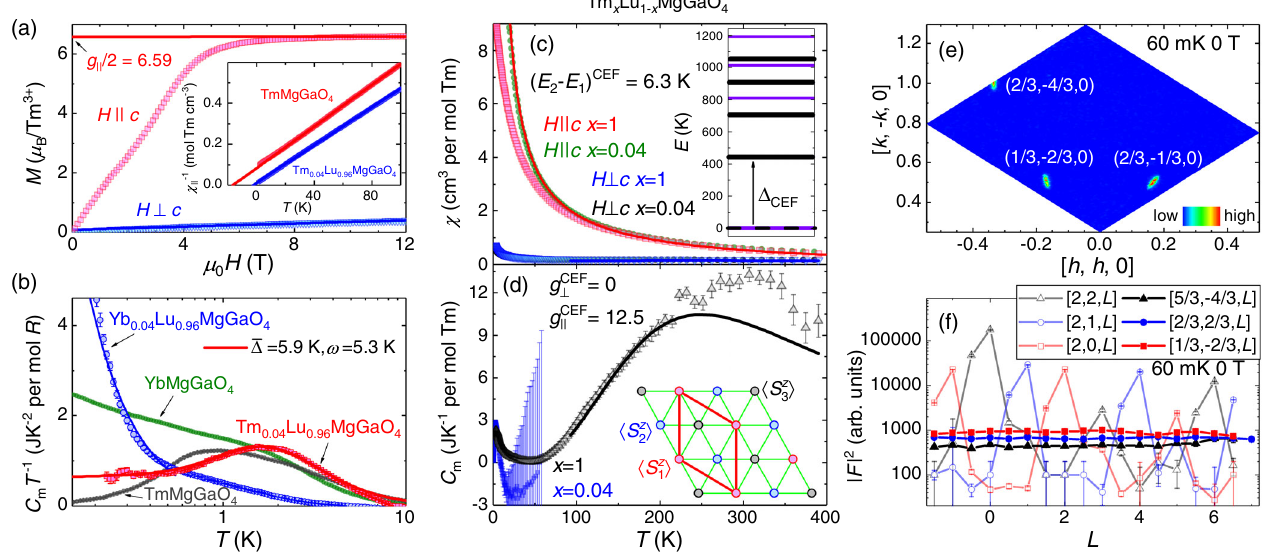
FIG. 1. (a) Magnetization of TmMgGaO 4 measured at 1.9 K in the fields parallel and perpendicular to the c axis. The colored lines show the linear fits to the data above 8 T. Inset: Curie-Weiss fits to the susceptibilities of TmMgGaO 4 and Tm 0 measured at 0.1 T along the c axis. (b) Magnetic heat capacities ( C Yb 0 Lu 0 MgGaO 4 at 0 T. The red and blue lines show, respectively, the fits to the data for Tm 0 . 04 . 96 Yb 0 Lu 0 MgGaO 4 with the Lorentzian distributions of E 2 − E 1 . (c) Temperature dependence of susceptibilities measured in the . 04 . 96 field of 0.05 Tapplied both parallel and perpendicular to the c axis. The inset shows the CEF levels from the combined CEF fit, with the black and violet lines for the CEF doublets and singlets, respectively. The GS quasidoublet is shown by the dark violet line. (d) Temperature dependence of the magnetic heat capacity measured at 0 T. The inset presents a sketch of the 2D three-sublattice magnetic dipole structure with the green and red lines showing the triangular lattice and the magnetic unit cell, respectively. The lines show the combined CEF fit to the magnetic data of TmMgGaO 4 above 90 K in both (c) and (d). (e) Magnetic neutron diffraction of TmMgGaO 4 measured on D23 at 60 mK and 0 T in the ab plane ( L ¼ 0 ). (f) L dependence of selected static structure factors measured on POLI at 60 mK and 0 T. The magnetic structure factors are normalized by the magnetic form factor of Tm 3 þ